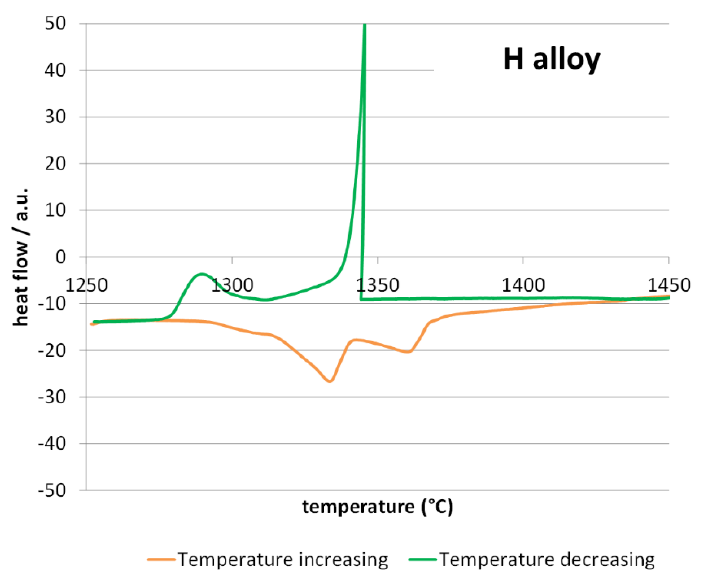
Figure 3. DTA curve obtained for the H alloy.